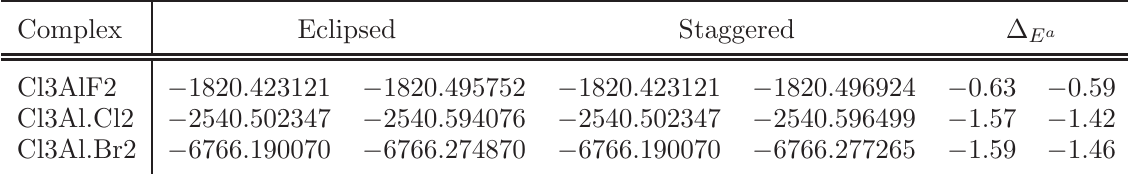
Table 3 MP2 and CCSD(T) total energies E T (a.u.) and relative energies Δ E (kcal/mol) (between the two conformations) of the Cl = F, Cl, and Br).